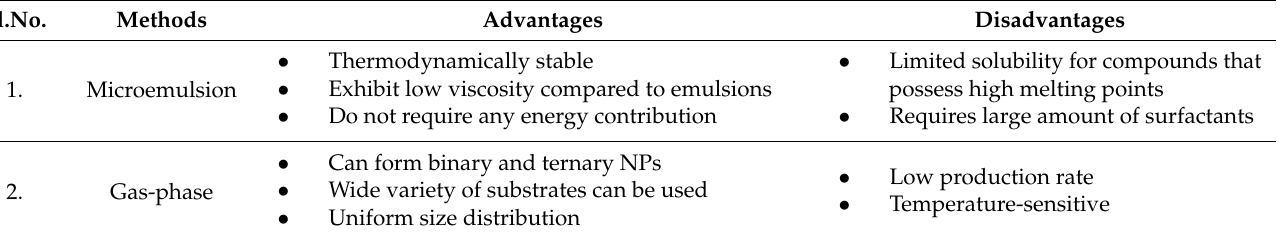
Table 1. Comparison of different synthetic routes in terms of advantages and